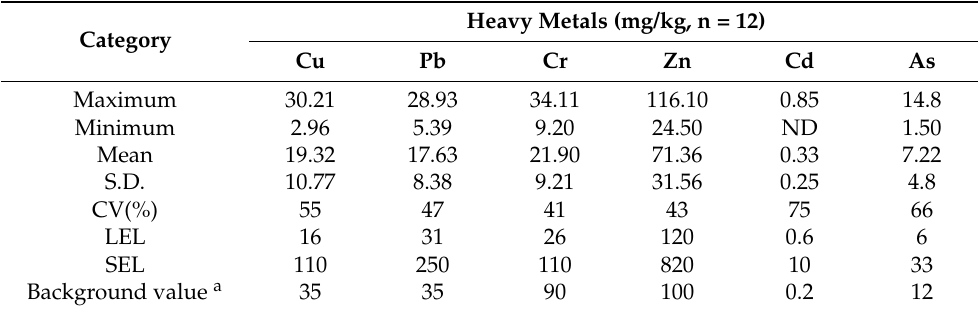
Table 1. Statistical results of heavy metals in Hulun Lake